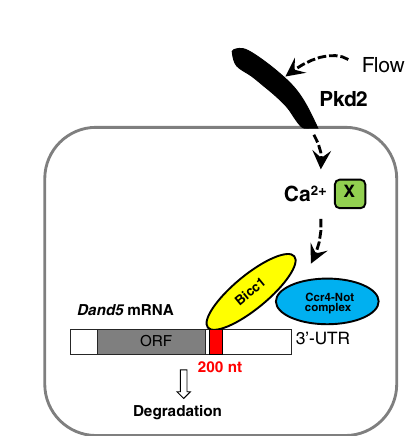
Fig. 9 Model for the degradation of Dand5 mRNA in crown cells of the node in response to nodal fl ow. See text for